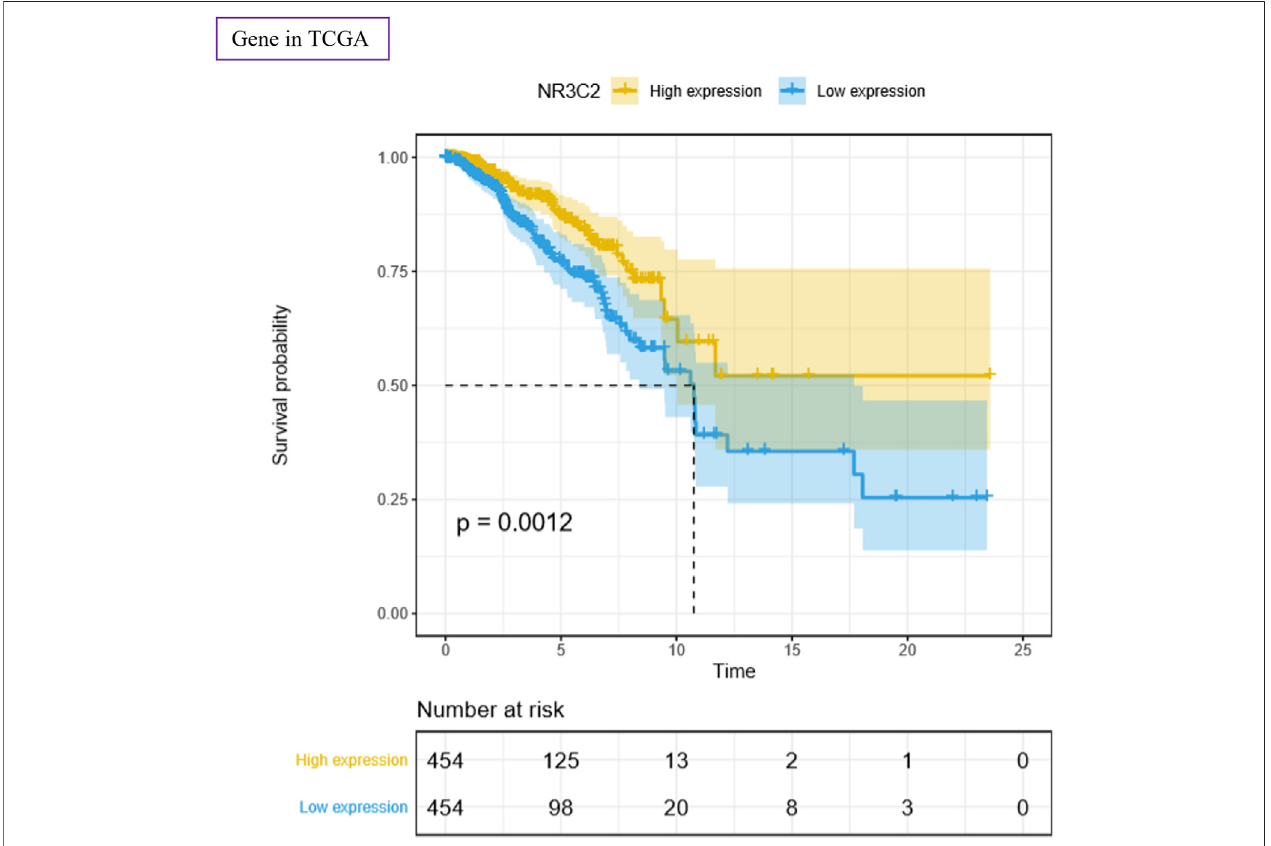
FIGURE 7 | Survival analyses of NR3C2 regarding OS using the TCGA – BRCA data set. Yellow: high-expression group; blue: low-expression group. p value was log-ranked. Auto-selected best cutoffs were used.